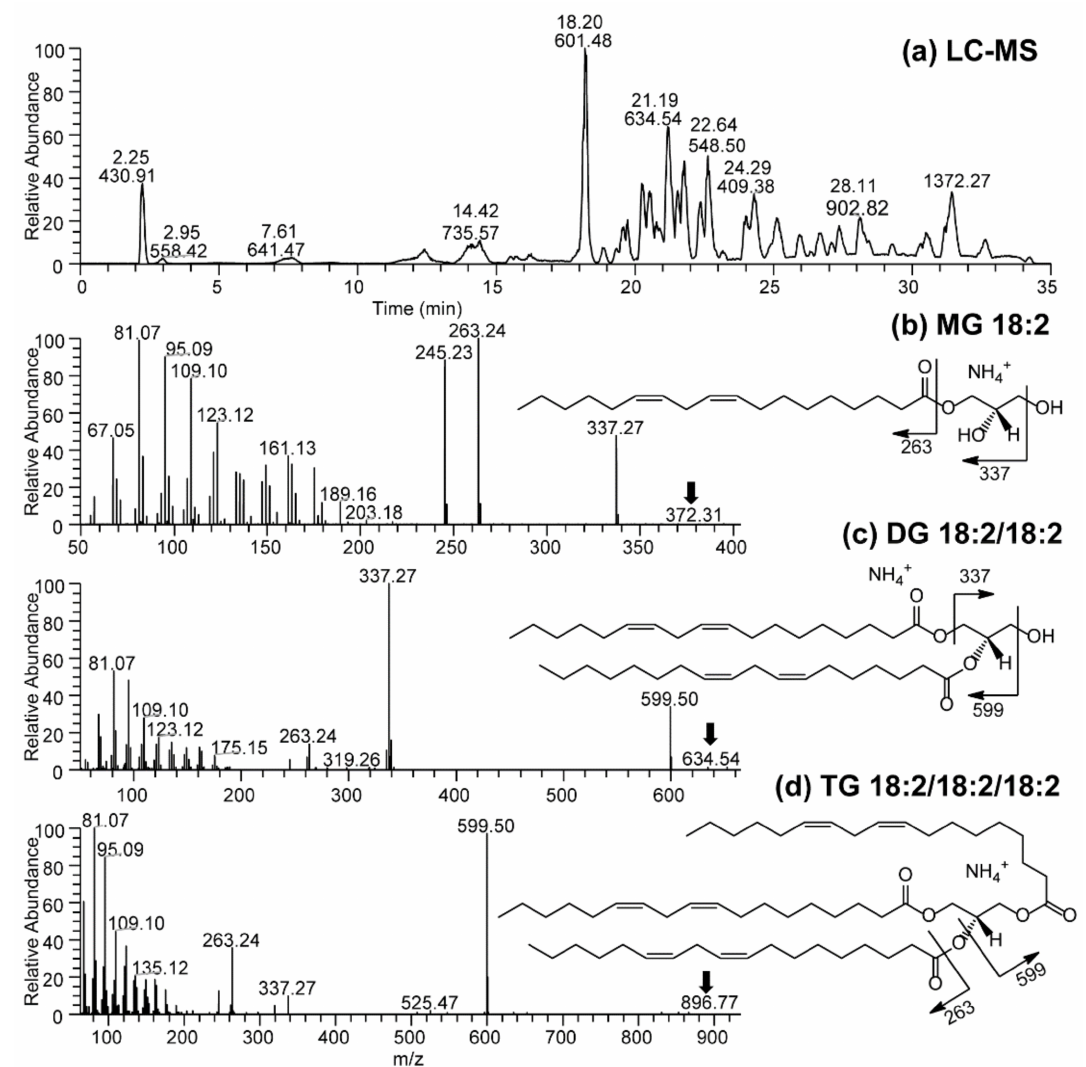
Figure 1. ( a ) UHPLC-MS chromatography and tandem mass spectra ( b – d ) of unsaponified monoacylglycerol (MG), diacylglycerol (DG), and triacylglycerol (TG) in base bar soaps,